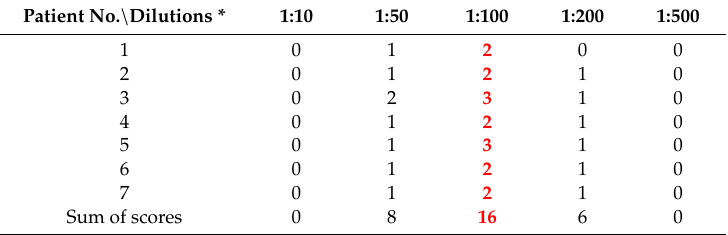
Table 4. Quality control of hPSA staining with antisense peptide dilutions, based on NordiQC scoring criteria: 0—Poor; 1—Borderline; 2—Good; 3—Optimal [57].